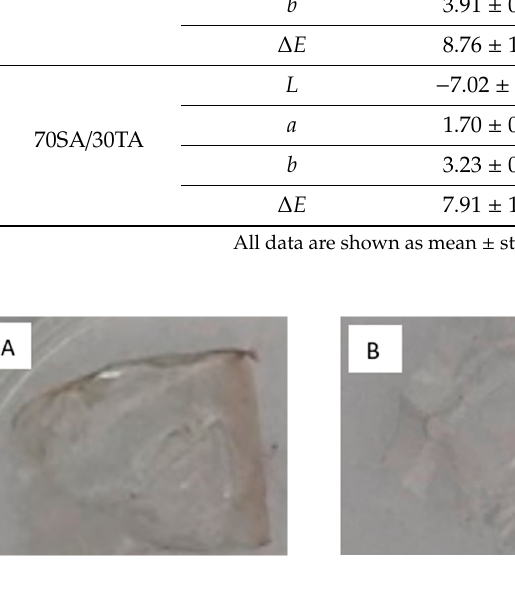
Table 3. Color parameters ( L—lightness, a—red ( + ) to green ( − ), b—yellow ( + ) to blue ( − b) and ∆ E—total color di ff erence ) of the films.